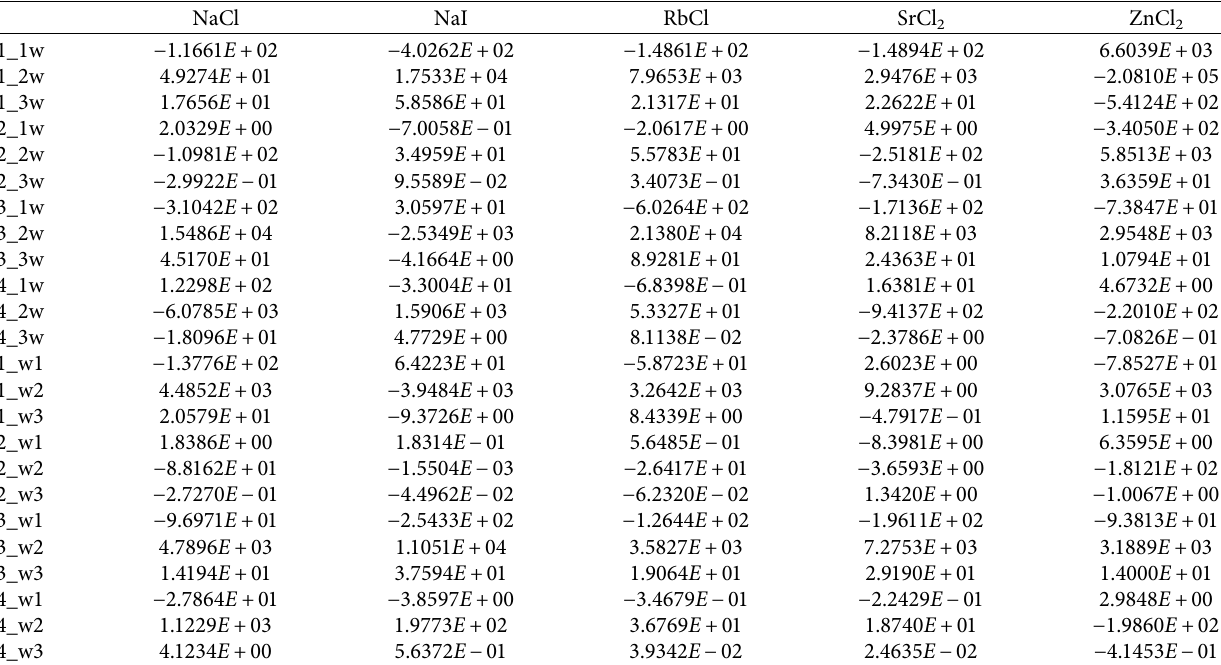
Table 4: Interaction parameters